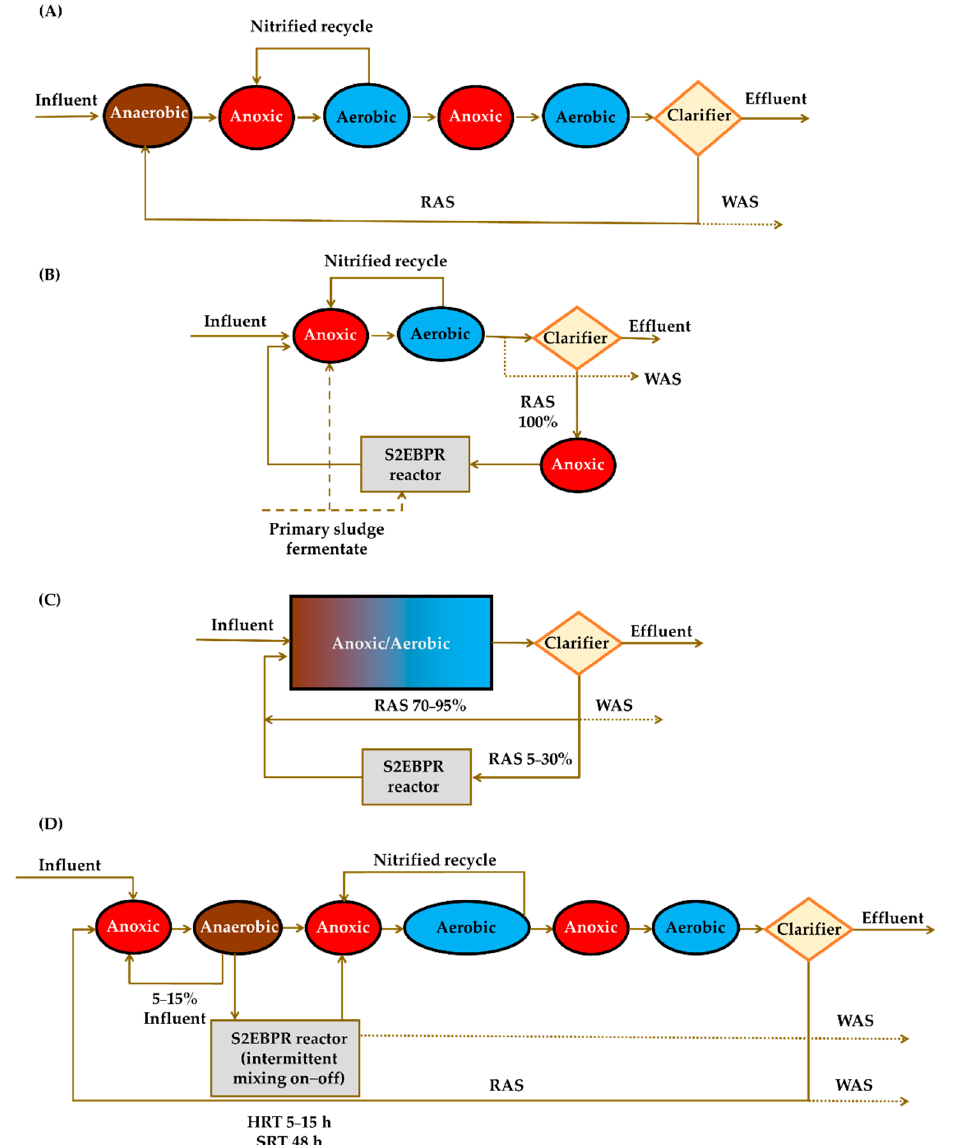
Figure 5. Examples of the mainstream EBPR system configurations (( A )—Bardenpho) and sidestream application (( B )—sidestream RAS plus carbon [SSRC], ( C )—sidestream RAS [SSR], ( D )—Sidestream Mixed Liquor Suspended Solids [SSM]). RAS—recirculated activated sludge, WAS—waste activated sludge, HRT—hydraulic retention time, SRT—sludge retention time.